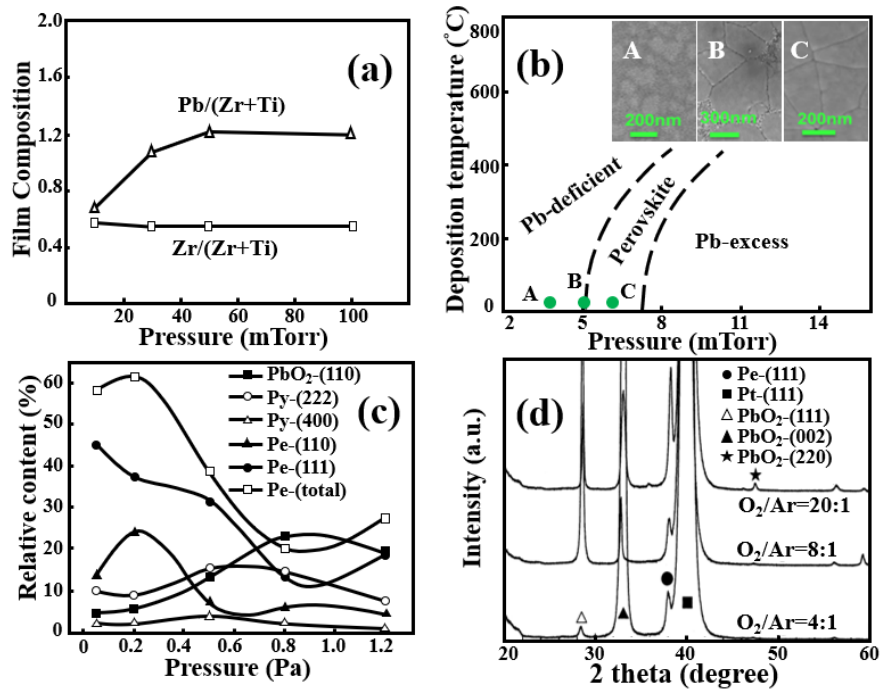
Figure 6. ( a ) Pressure dependence of film composition. Reprinted with permission from [47] Copyright 1997 Elsevier; ( b ) schematic phase diagram of PZT thin films as a function of pressure and deposition temperature; the inset is surface morphology of samples A–C. Reprinted with permission from [11] Copyright 2018 John Wiley and Sons; ( c ) phase structure and orientation evolutions of PZT thin film deposited at different pressure [49]; ( d ) XRD patterns of PZT thin film deposited at different O 2 /Ar ratios. Reprinted with permission from [50] Copyright 2000 Elsevier.